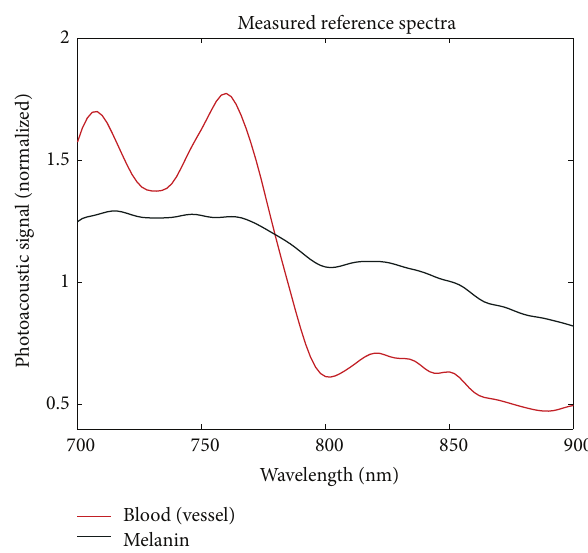
Figure 2: Normalized measured reference spectra for blood and melanin. The spectral differences between blood and melanoma are best reflected in the gradual slope of melanoma compared to the increase of blood in the wavelength range between 732 and 756